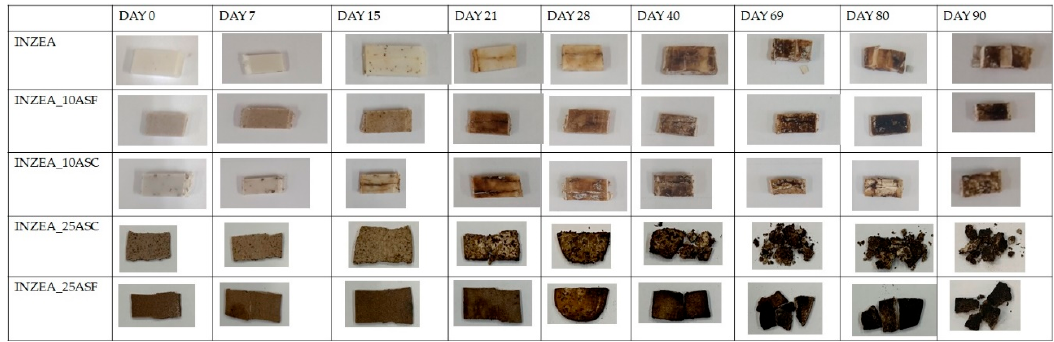
Figure 6. Visual appearance of INZEA-based biocomposites with 10 and 25 wt % of ASP at two grinding levels (F, C) at different testing days at 58 °C.